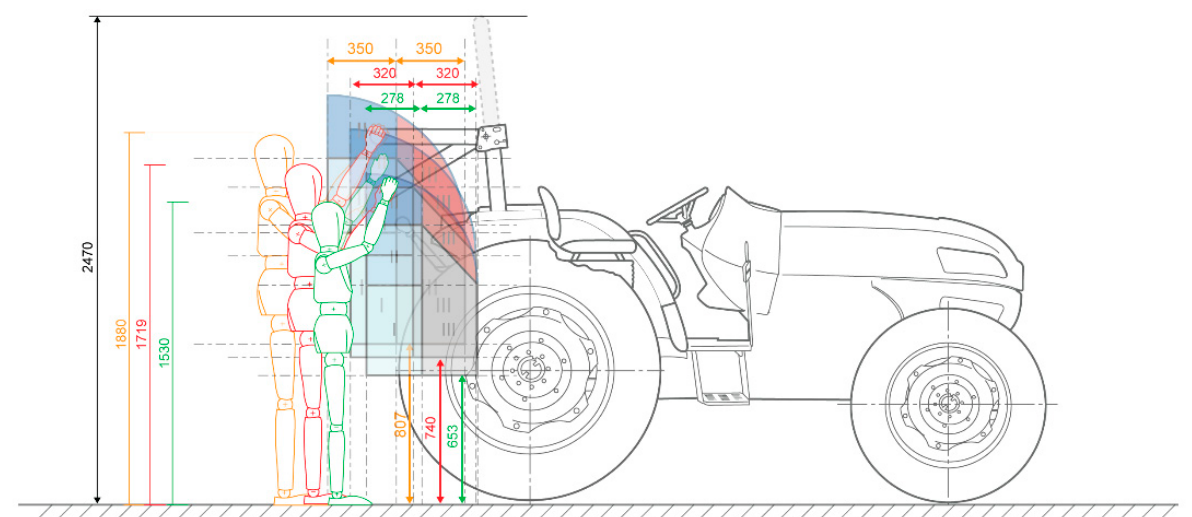
Figure 7. The three percentiles figures and their respective accessible zones,